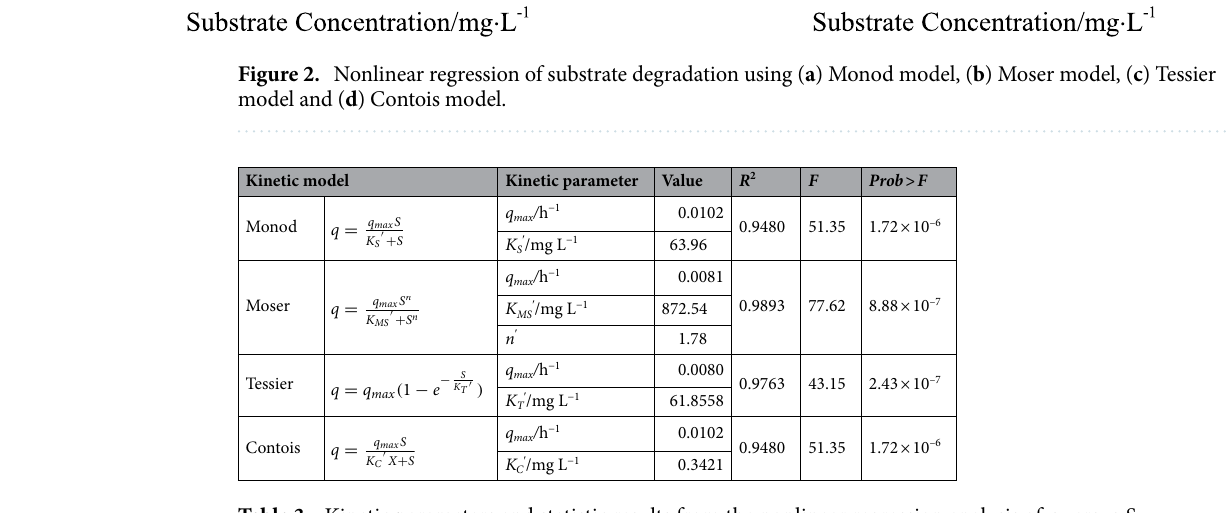
Table 3. Kinetic parameters and statistic results from the nonlinear regression analysis of q versus S .